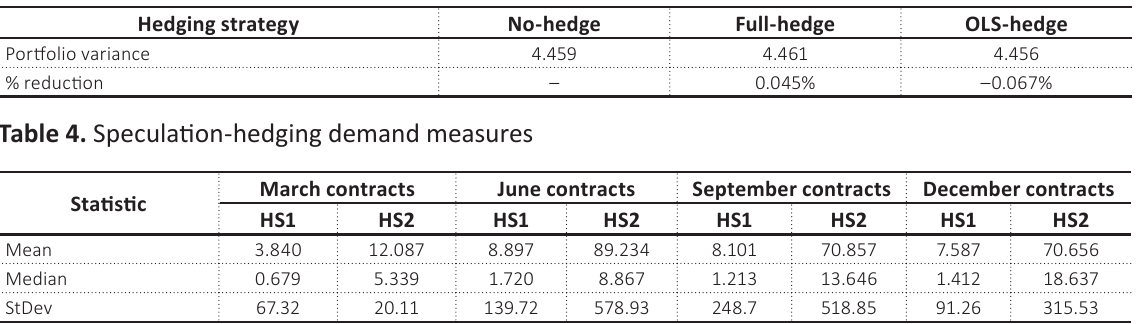
Table 3. Hedging Bitcoin spot with Bitcoin futures